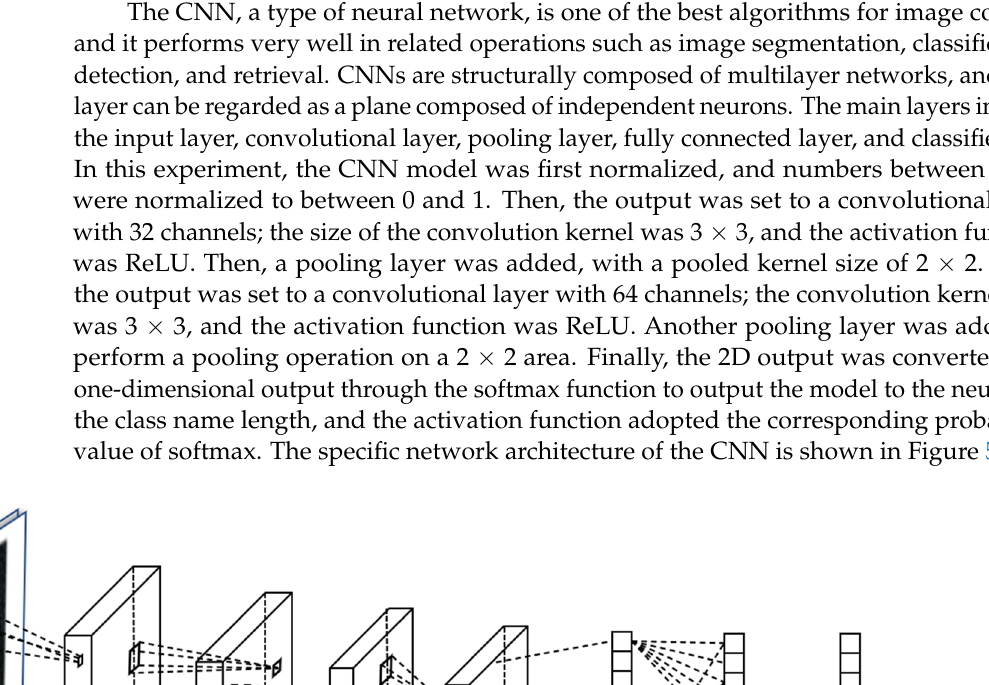
Figure 4. Calculated image histogram.